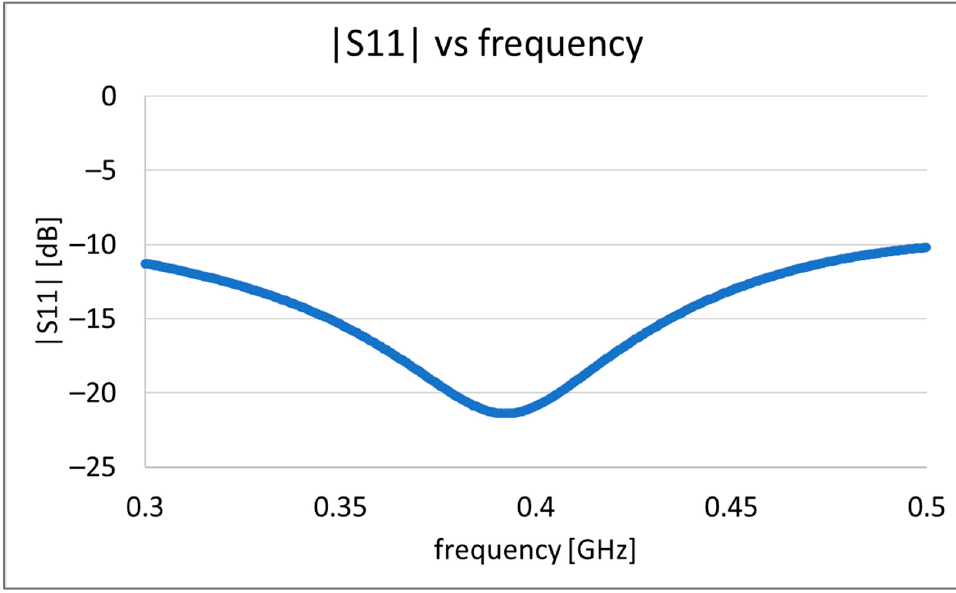
Figure 11. Impedance matching of the antenna placed in capsule model fabricated of PLA.